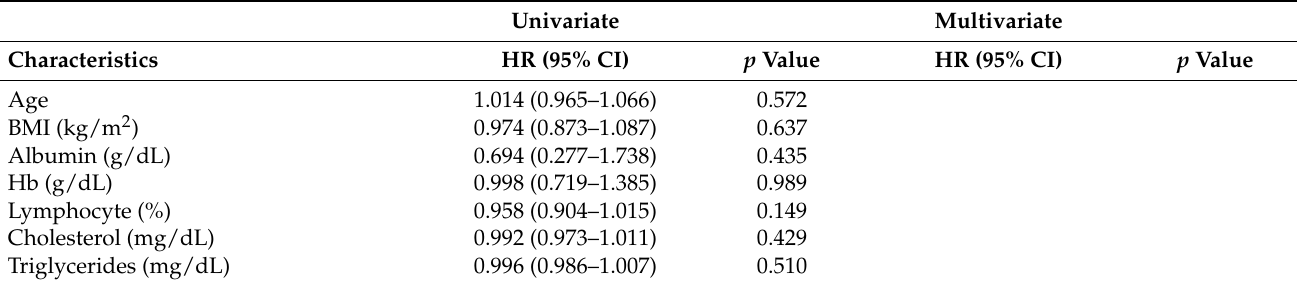
Table 3. Univariate and multivariate Cox proportional hazards model for progression-free survival. Univariate